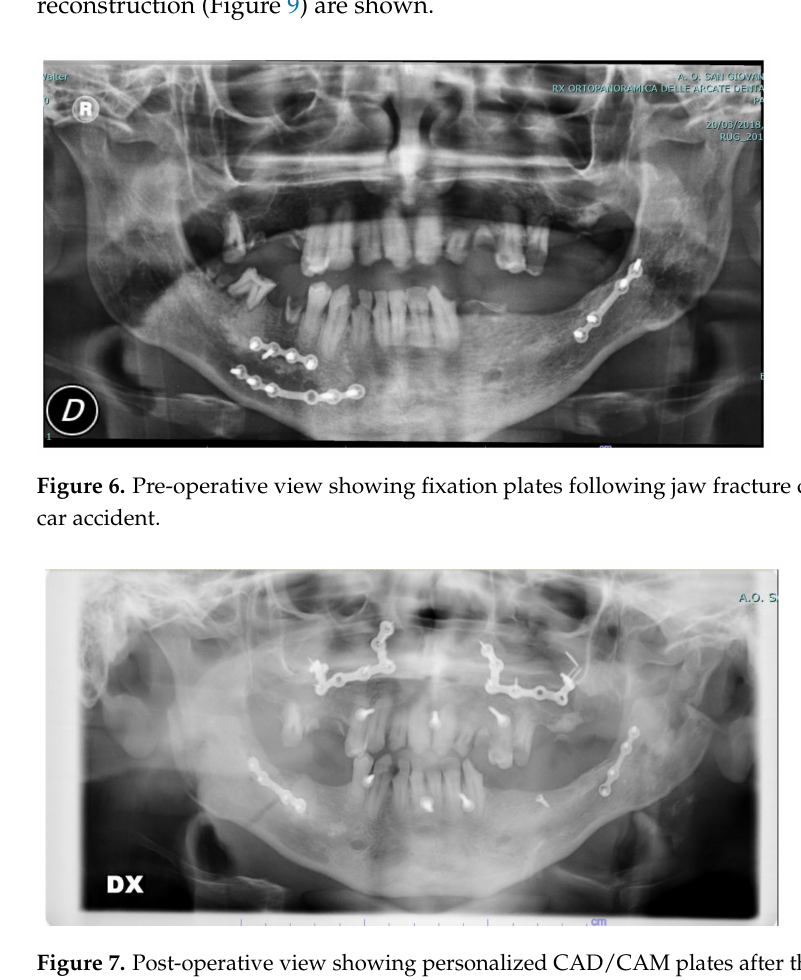
Figure 7. Post-operative view showing personalized CAD/CAM plates after the previously installed plates removal and orthognathic surgery class III